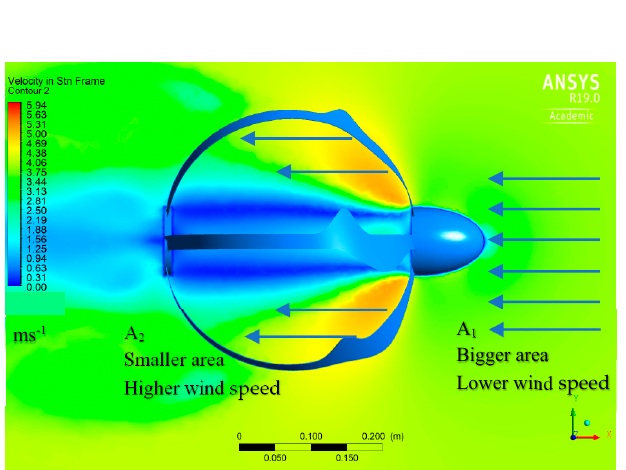
Figure 13. Velocity distribution around the energy ball.